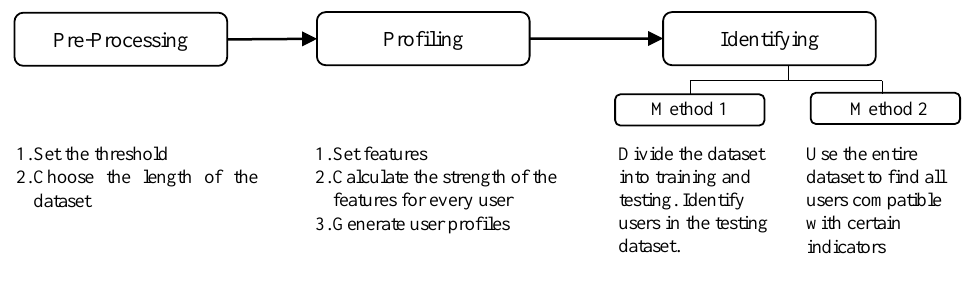
Fig. 3. User identification steps using smartphone usage